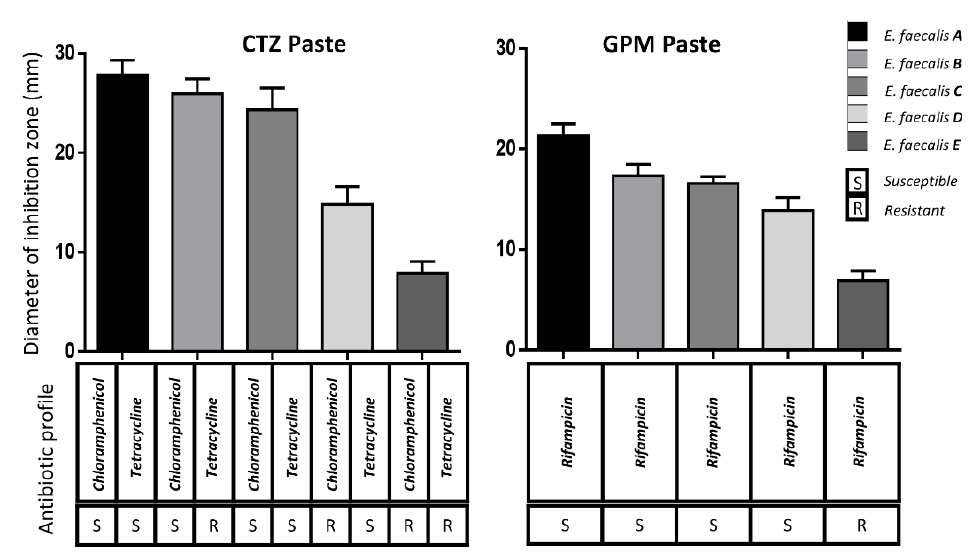
Figure 2. Average and standard deviation of the inhibition zones on the five different E. faecalis strains with the use of CTZ and GPM pastes. Under the bars, the specific antibiotic profile of each strain is shown. The comparisons with no differences ( p > 0.05) were the strains A vs. B and B vs. C when CTZ paste was used, and the strains B vs. C when GPM paste was used. Two-way ANOVA and post hoc Tukey–Kramer multiple comparisons test were applied.